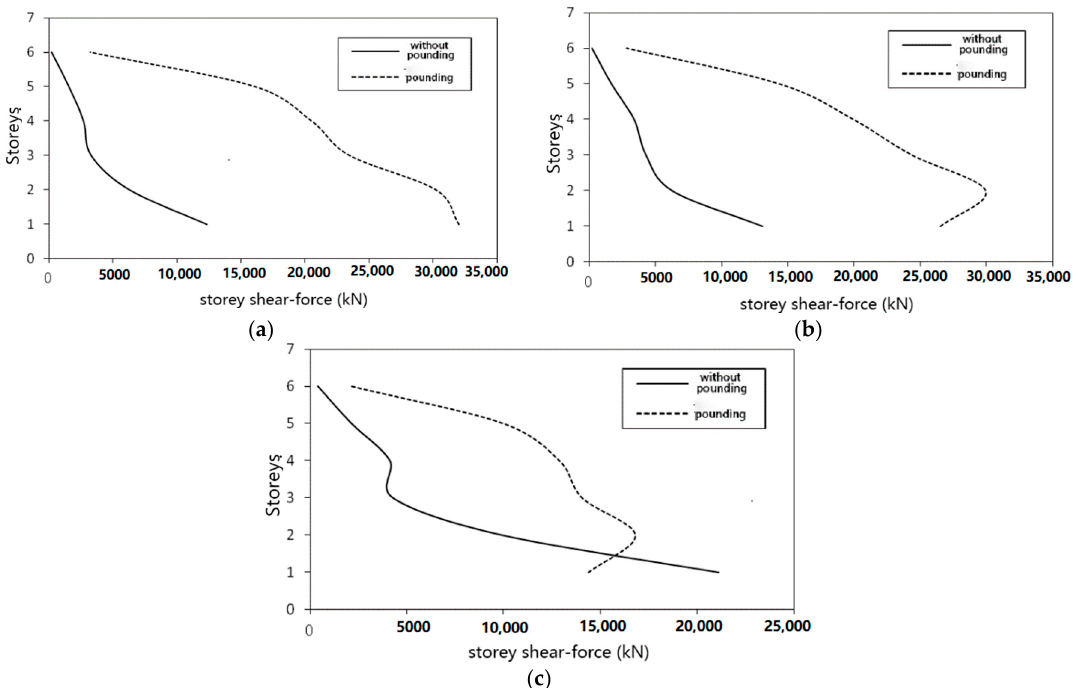
Figure 15. Story shear-force under different earthquakes (model B). ( a ) El Centro earthquake; ( b ) Taft earthquake; ( c ) Artificial excitation.